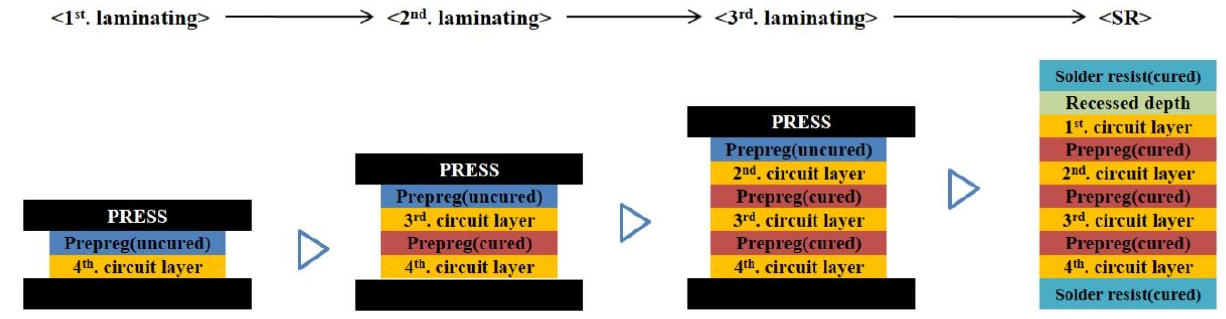
Figure 13. PPG and SR laminating process.